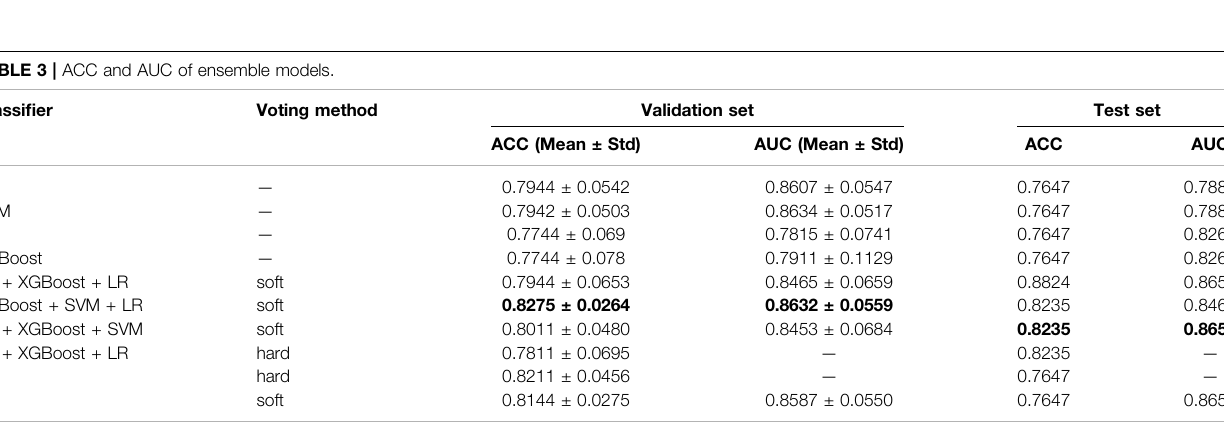
TABLE 3 | ACC and AUC of ensemble models.